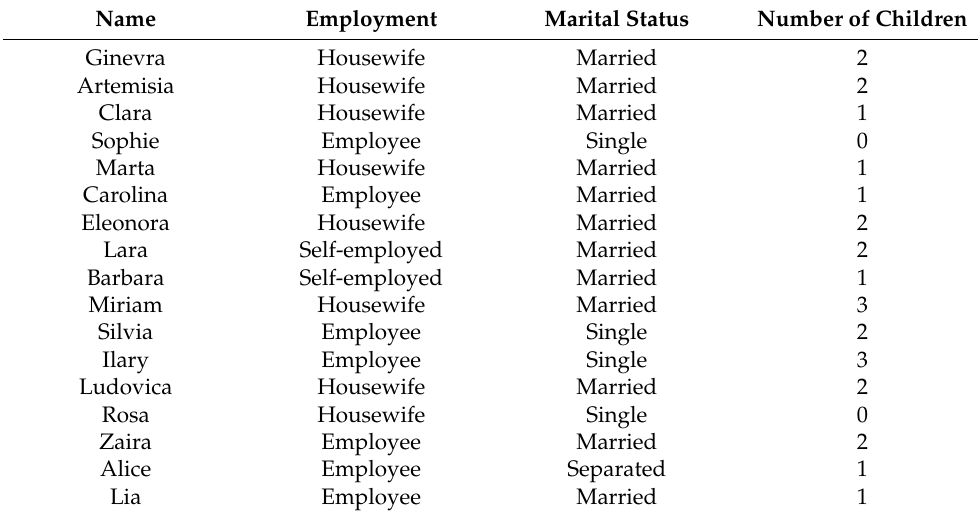
Table 1. Sociodemographic characteristics of the breast cancer patients monitored during the four phases of the medical treatment. Pseudonyms are used to protect patient